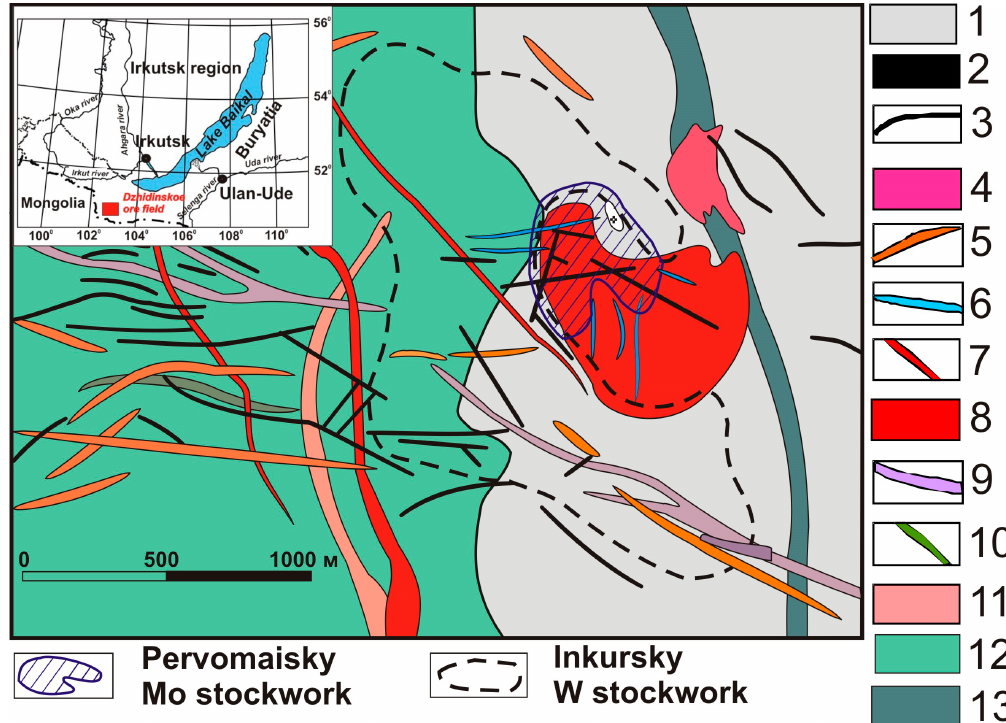
Figure 1. ( a ) Abandoned quarry at the Pervomaiskoe deposit; ( b ) quartz-molybdenite veinlets in the Pervomaisky stock granites.